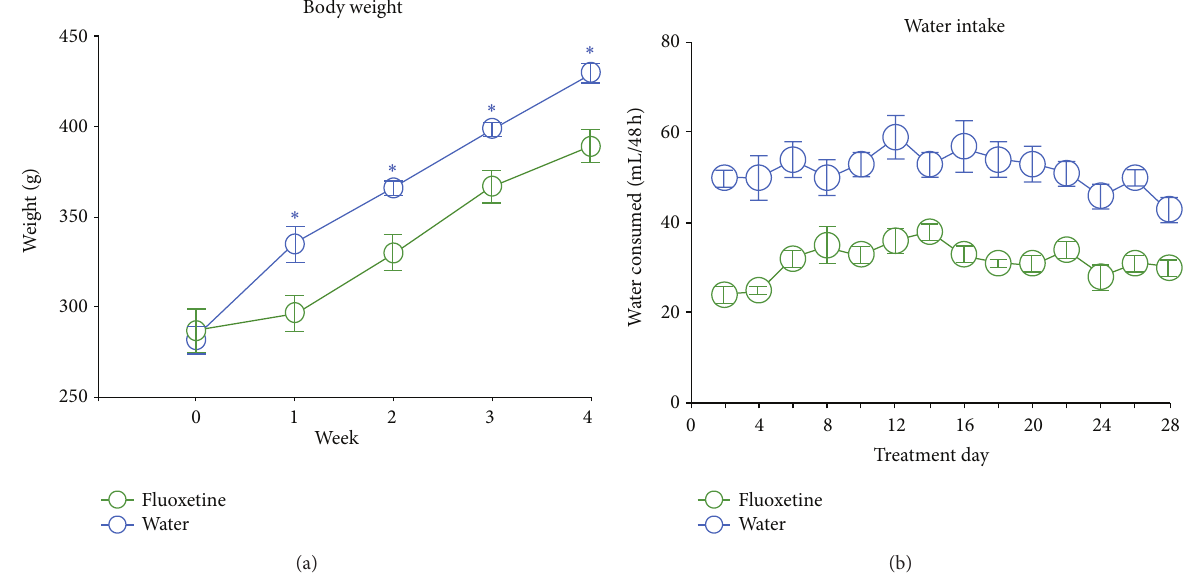
Figure 1: Body weight and water intake of rats given access to drinking water ( 𝑛 = 18 ) or drinking water containing fluoxetine (0.2 mg/mL; 𝑛 = 20 ) during a 4-week treatment period. (a) Fluoxetine treatment significantly reduced body weight gain during the treatment period. ANOVA results: effect of time, 𝐹(4,144) = 370.8 , 𝑃 < 0.0001 ; effect of group, 𝐹(1,36) = 5.8 , 𝑃 = 0.02 ; interaction, 𝐹(4,144) = 13.8 , 𝑃 < 0.0001 ; ∗ indicates significant ( 𝑃 < 0.05 ) simple effects tests. (b) Fluoxetine also reduced fluid intake relative to the control (water) condition during the entire treatment period. ANOVA results: effect of time, 𝐹(13,286) = 2.3 , 𝑃 = 0.006 ; effect of group, 𝐹(1, 22) = 43.9 , 𝑃 < 0.0001 ; interaction, 𝐹(13, 286) = 0.9 , 𝑃 = 0.6 . Note that statistics for fluid intake are limited to 𝑛 = 12 for both groups since some of the water bottles used did not permit accurate measurement of fluid